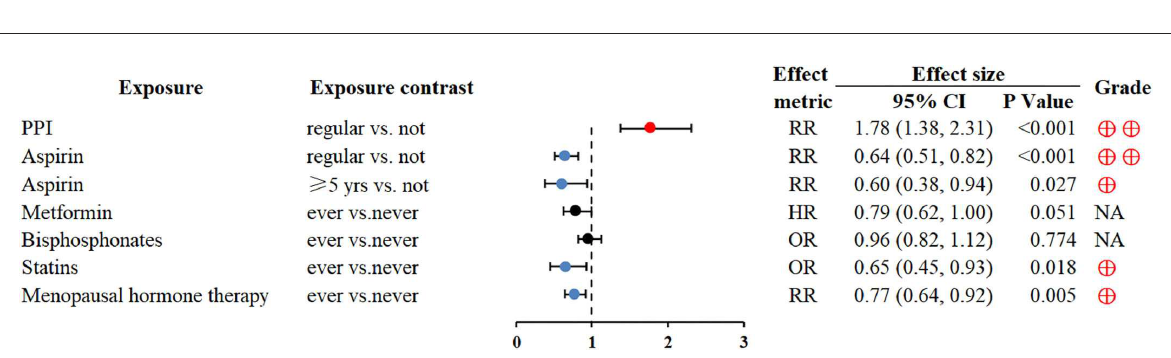
FIGURE5 Forest plot: summary effect estimates of meta-analyses reporting associations between GC and factors pertaining to use of medication. PPI, proton pump inhibitors.